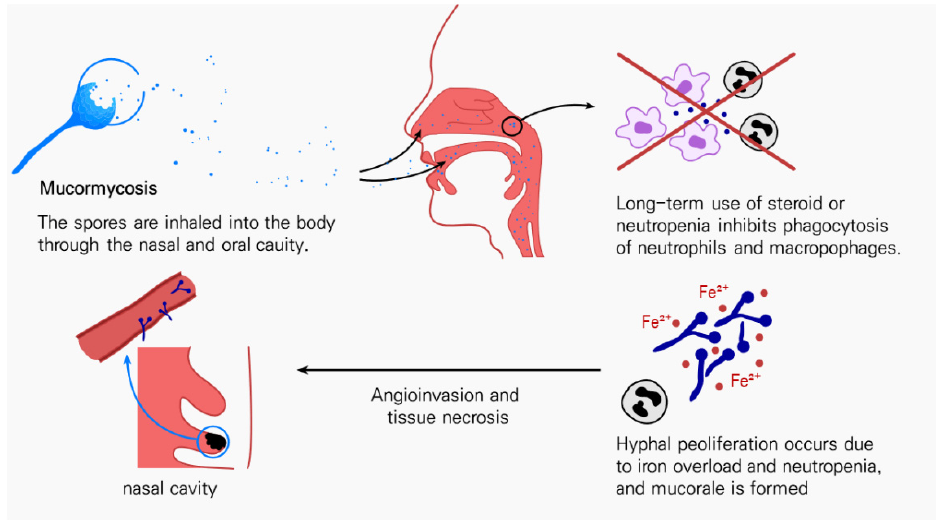
Figure 1. Pathogenesis of mucormycosis.